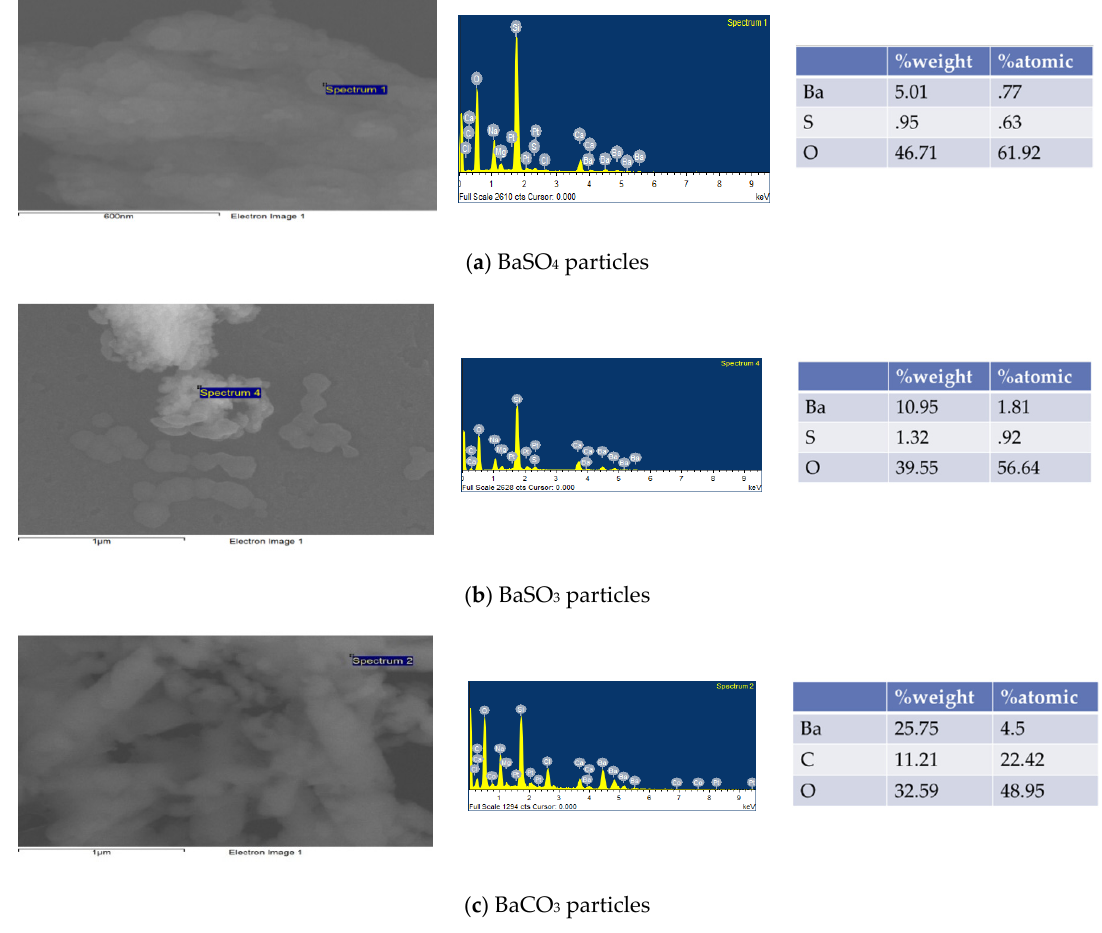
Figure 4. Element analysis of Ba salt particles. ( a ) The presence of Ba, S, and O elements in the sample for BaSO 4 particles. ( b ) Presence of Ba, S, and O elements in the sample for BaSO 3 particles. ( c ) The presence of Ba, C, and O elements in the sample for BaCO 3 particles.